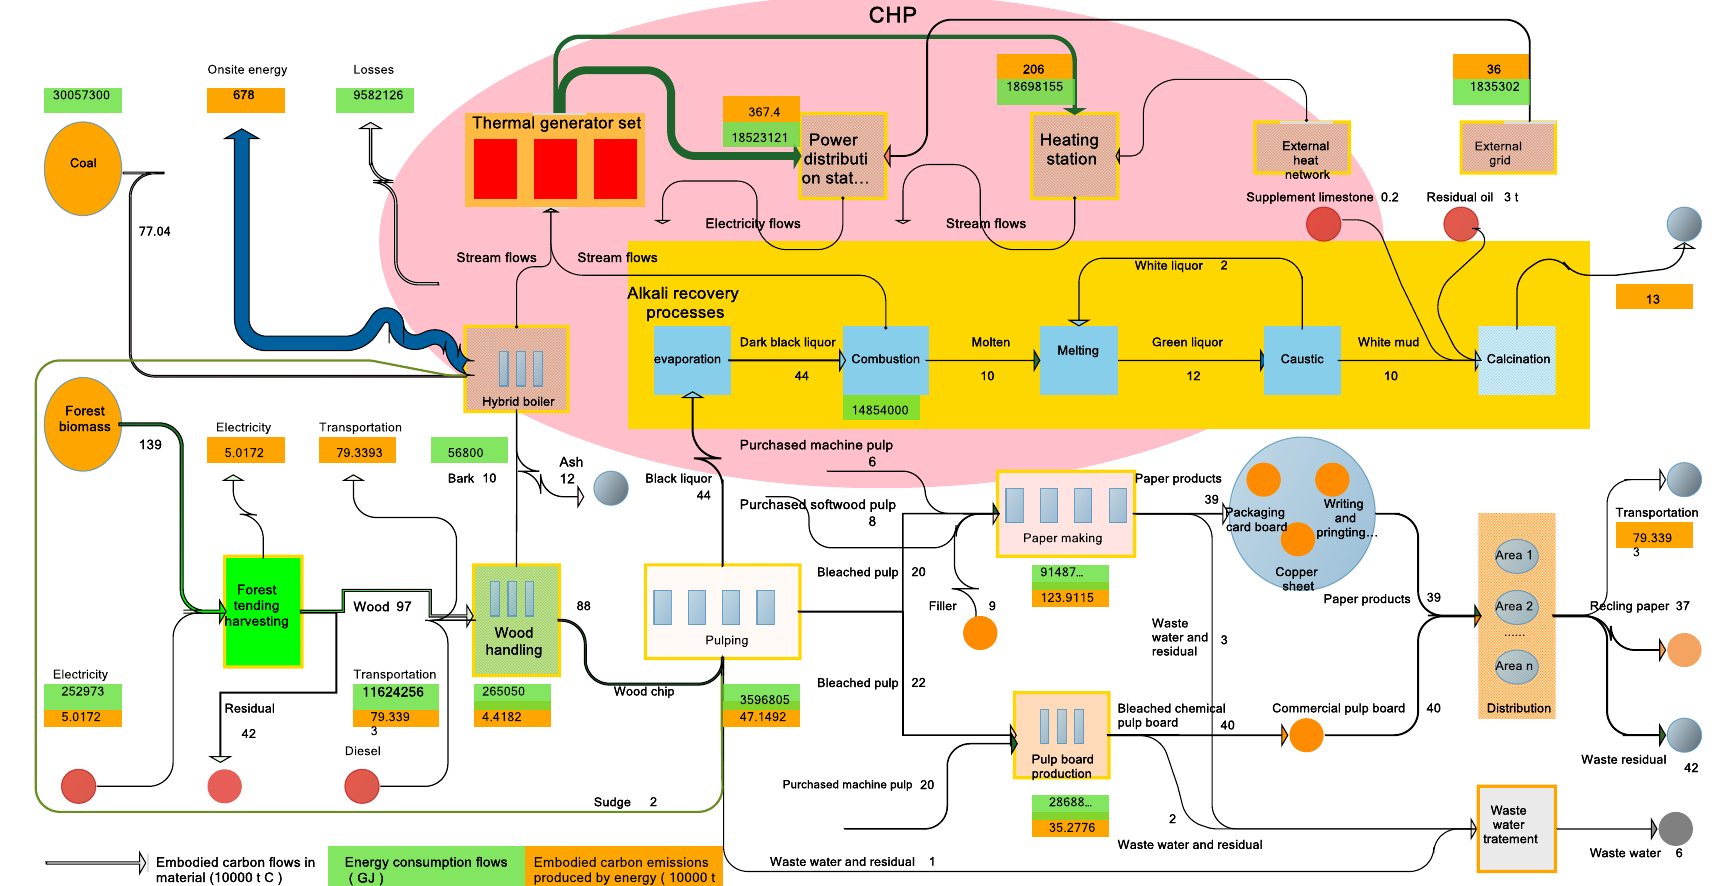
Figure 10. Flowchart of energy flows, embodied carbon flows and emissions in the forestry-pulp and paper industry (Units: Energy, GJ; embodied carbon flows, 10,000 t C; carbon emissions, t CO 2 -equiv).